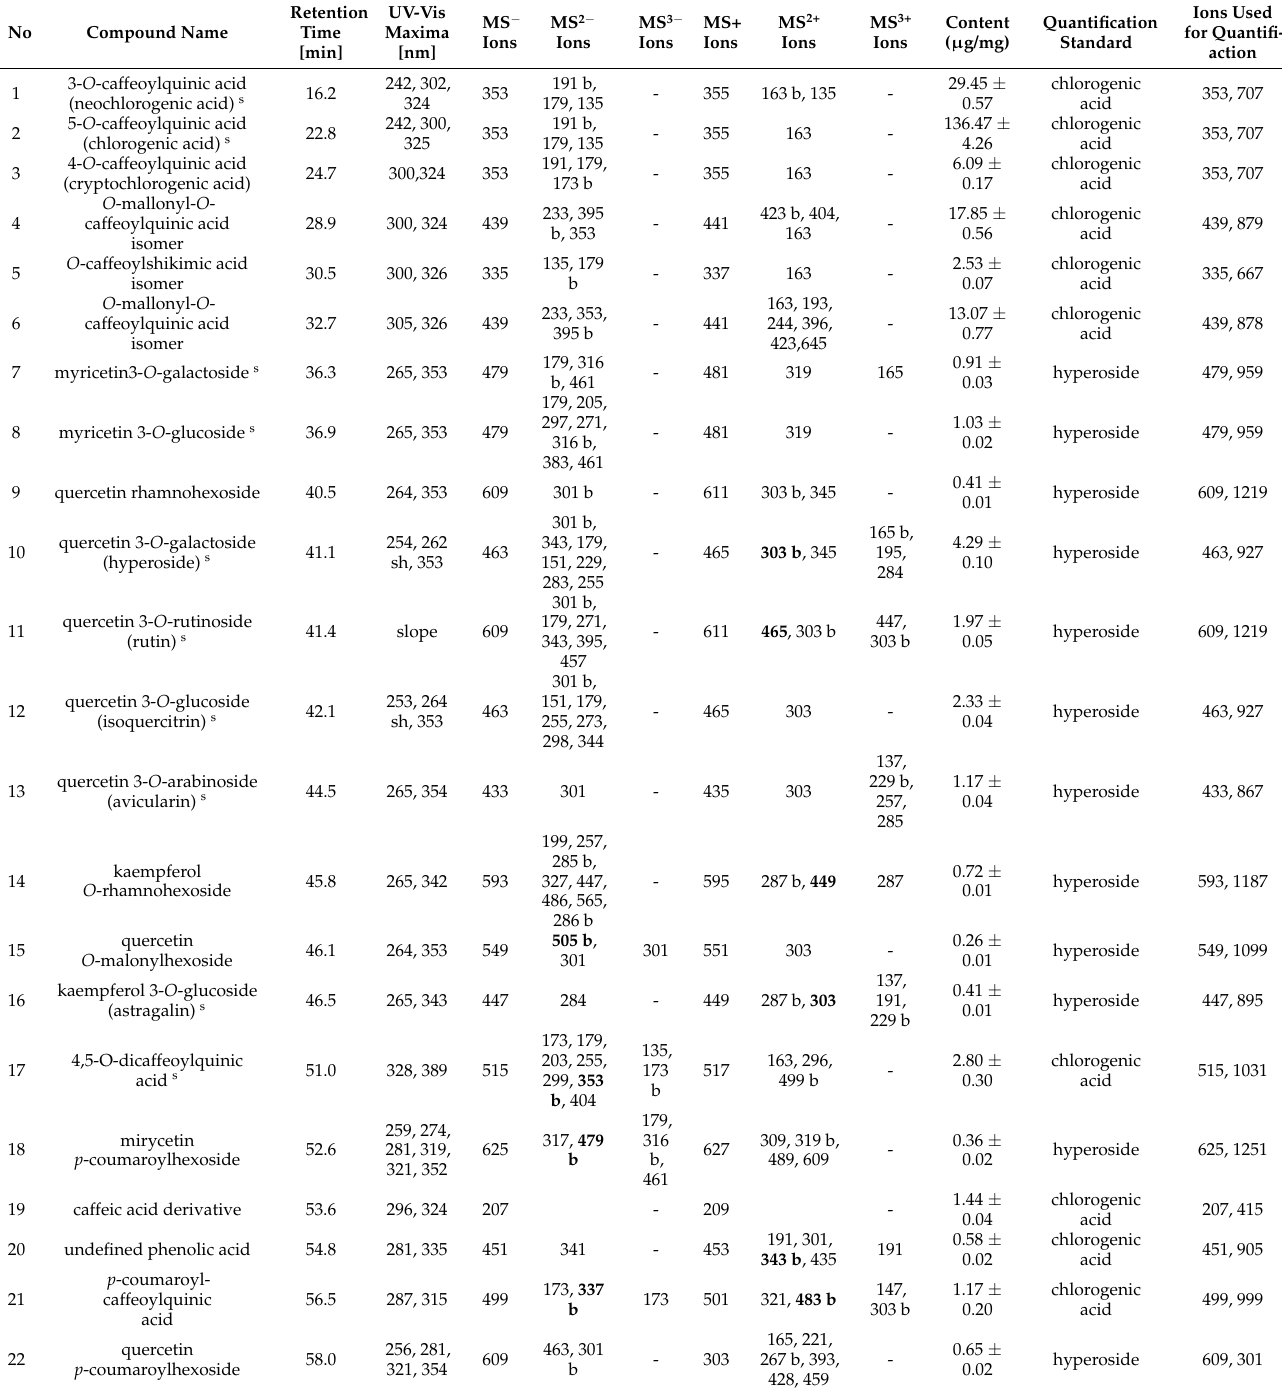
Table 1. Chemical composition of raw extract (E1) and quantification of major compounds using